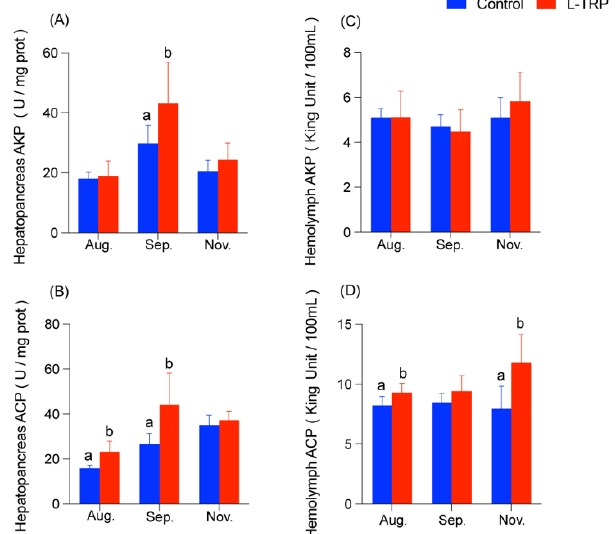
Figure 1. Effects of L-TRP supplementation on the AKP and ACP activities in hepatopancreas ( A , B ) and hemolymph ( C , D ) of E. sinensis at different sampling points (August, September and November). AKP: alkaline phosphatase; ACP: acid phosphatase. The values are expressed as the means ± SD (N = 8). Different letters above the column indicate the significant differences between the control and L-TRP groups ( p < 0.05).